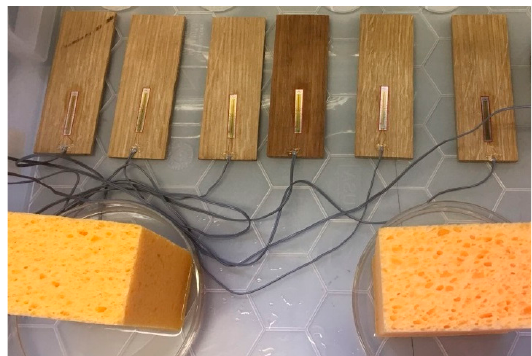
Figure 2. Picture of the experimental setup. Six wood panes with strain gauges adhered. Petri dishes with sponges soaked in water are used as humidity